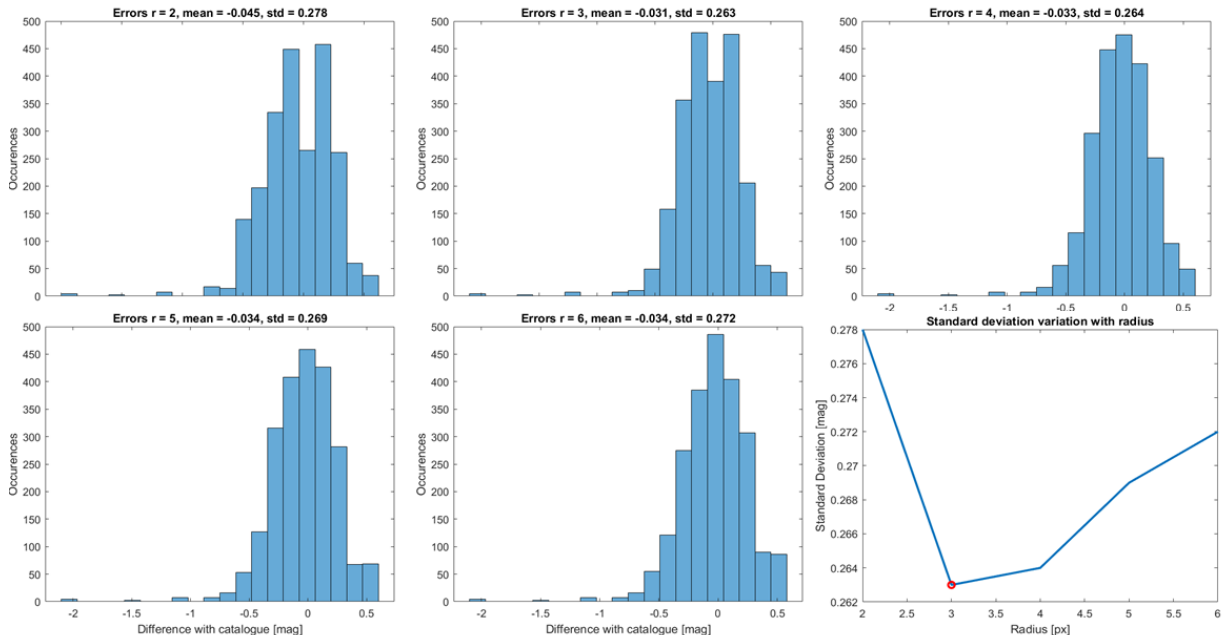
Figure 4. Optimum radius identification: standard deviation and mean of the error for each radius used for analyzing the example video.